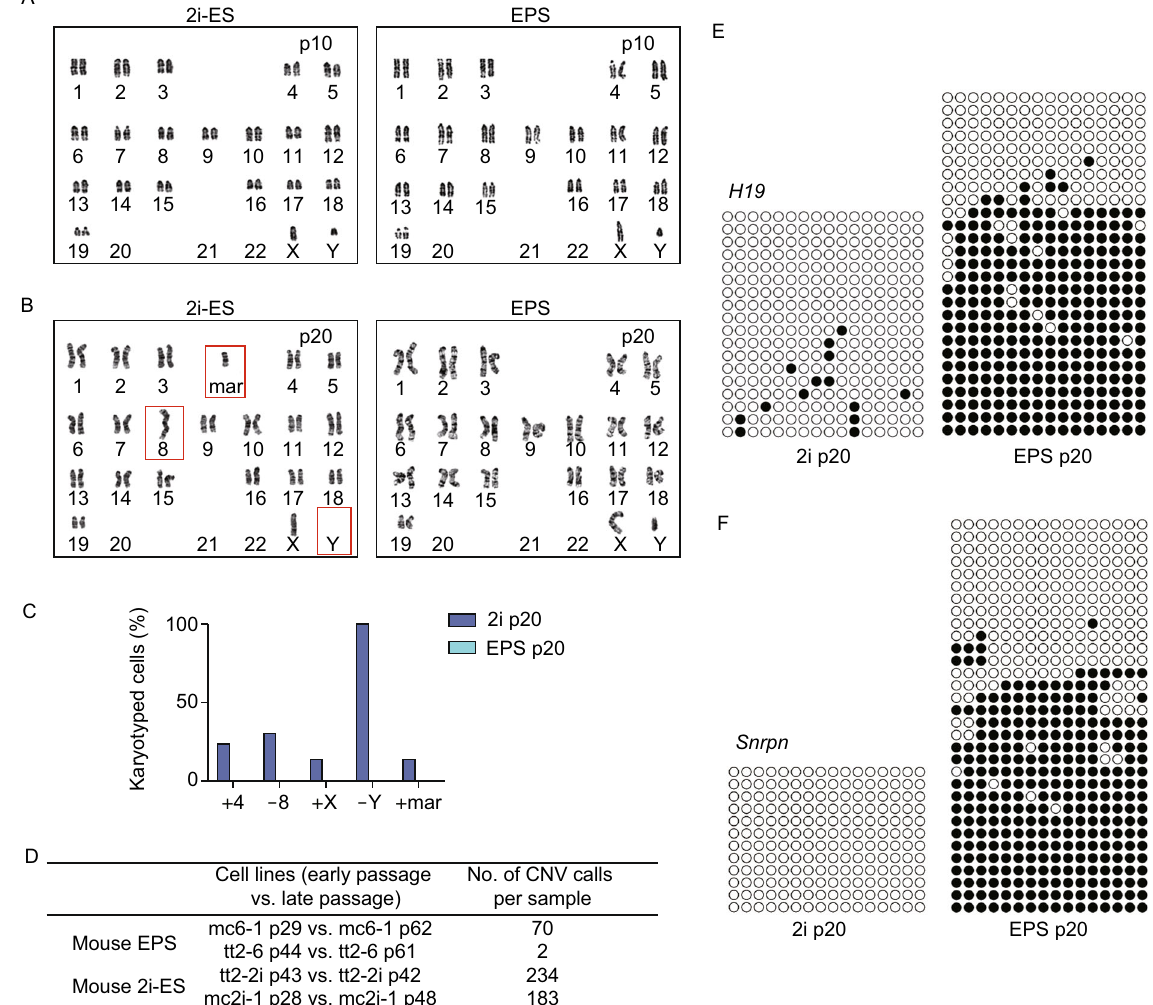
Figure 2. EPS cells are more stable than 2i cells at both the genetic and epigenetic levels. (A and B) Karyotype analysis of 2i- ES cells and EPS cells. Cells were collected at the indicated passage. (C) Percentage of cells with abnormal karyotype in 2i-ES cells and EPS cells. 30 2i-ES cells and 30 EPS cells at metaphase were analyzed. (D) CNVs in EPS cells and 2i-ES cells analyzed by CGH pro fi ling. (E and F) DNA methylation status of H19 (E) and Snrpn (F) in 2i-ES cells and EPS cells at passage 20. DNA methylation pro fi les were assayed by the bisul fi te sequencing assay. Each line represents an individual clone allele. Each circle within the row represents a single CpG site (open and closed circles represent unmethylated and methylated CpGs,